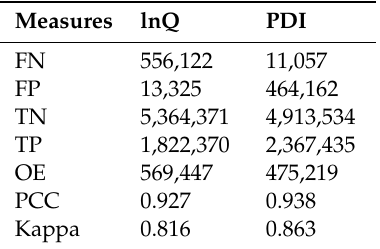
Table 2. Accuracy assessment of the change detection maps obtained by both